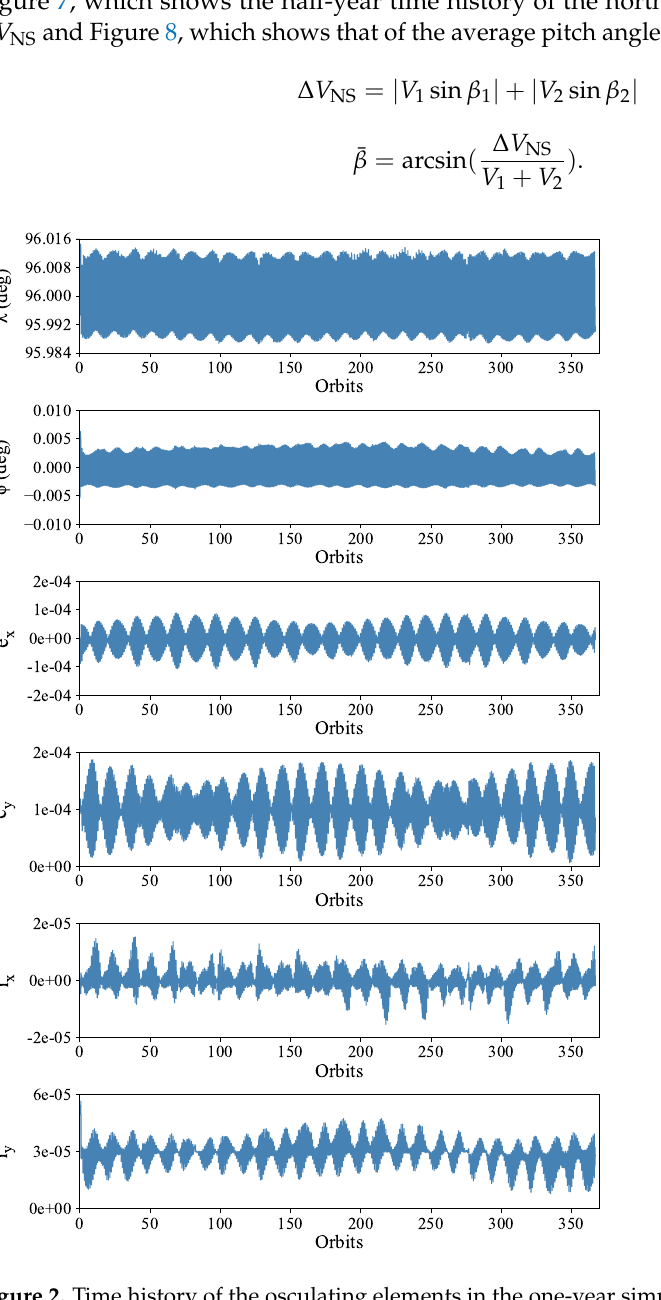
Figure 2. Time history of the osculating elements in the one-year simulation for the